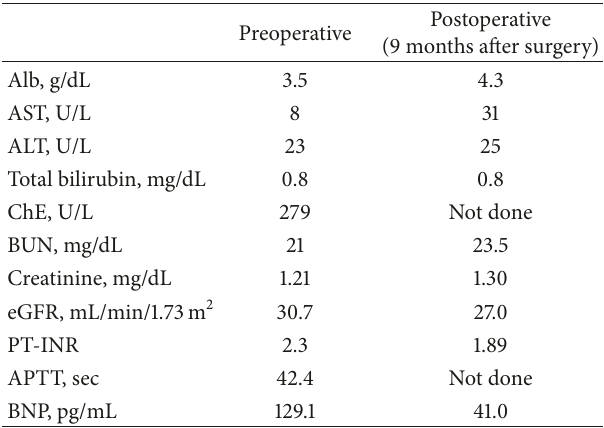
Table 1: Pre- and postoperative laboratory data. Postoperative Preoperative (9 months after